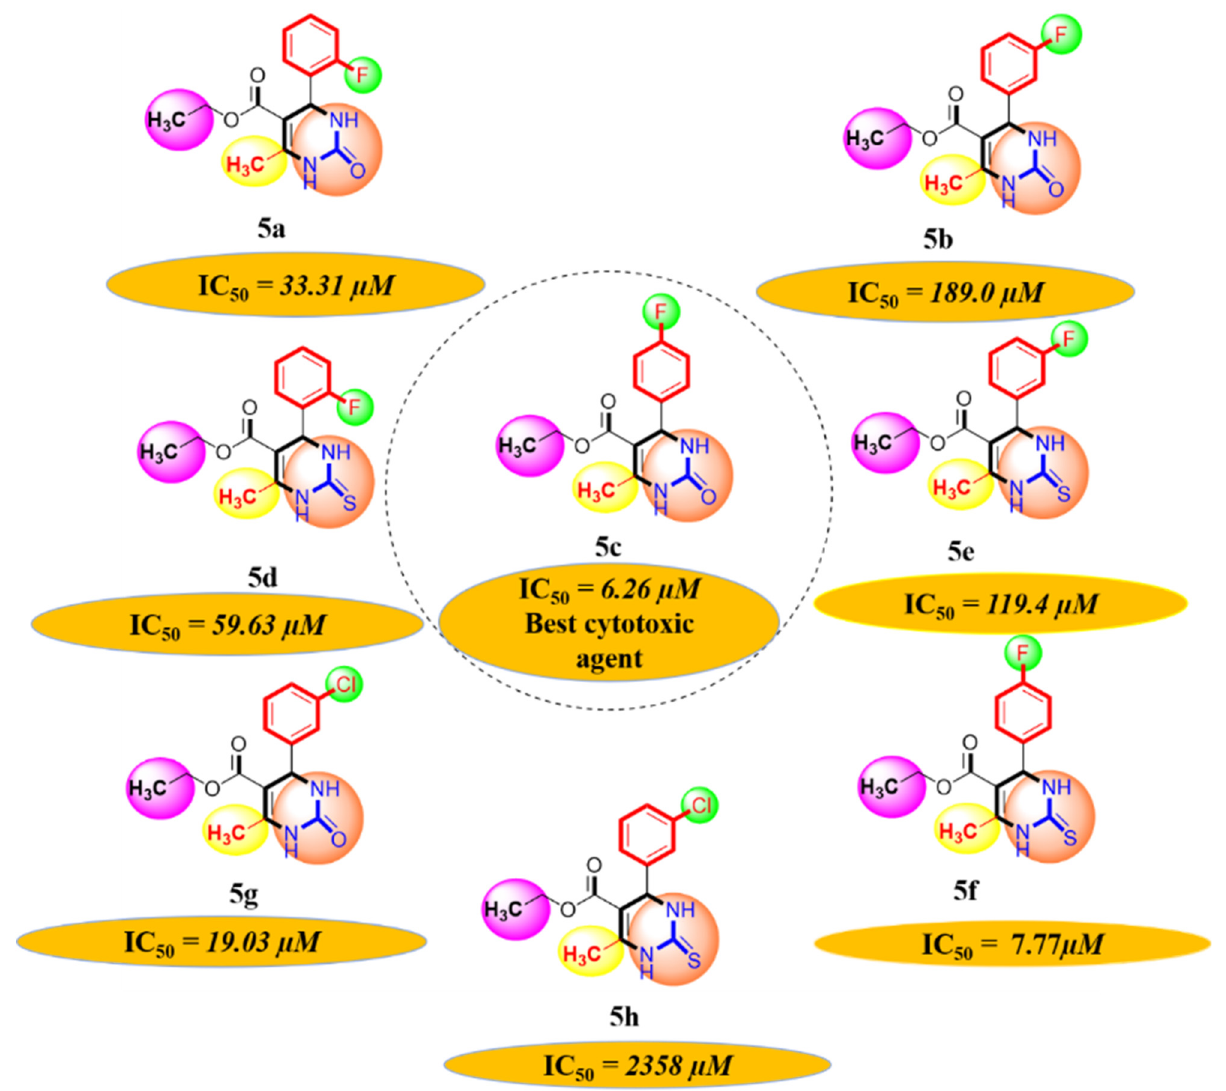
Figure 7. Diagrammatic relationship of target molecules ( 5a–h ) for their structure-activity relationship as anti-oxidant agents.